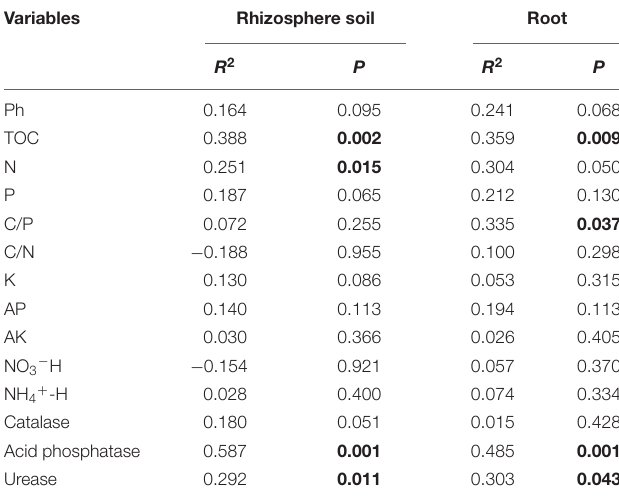
P-values in bold are statistically significant (p <